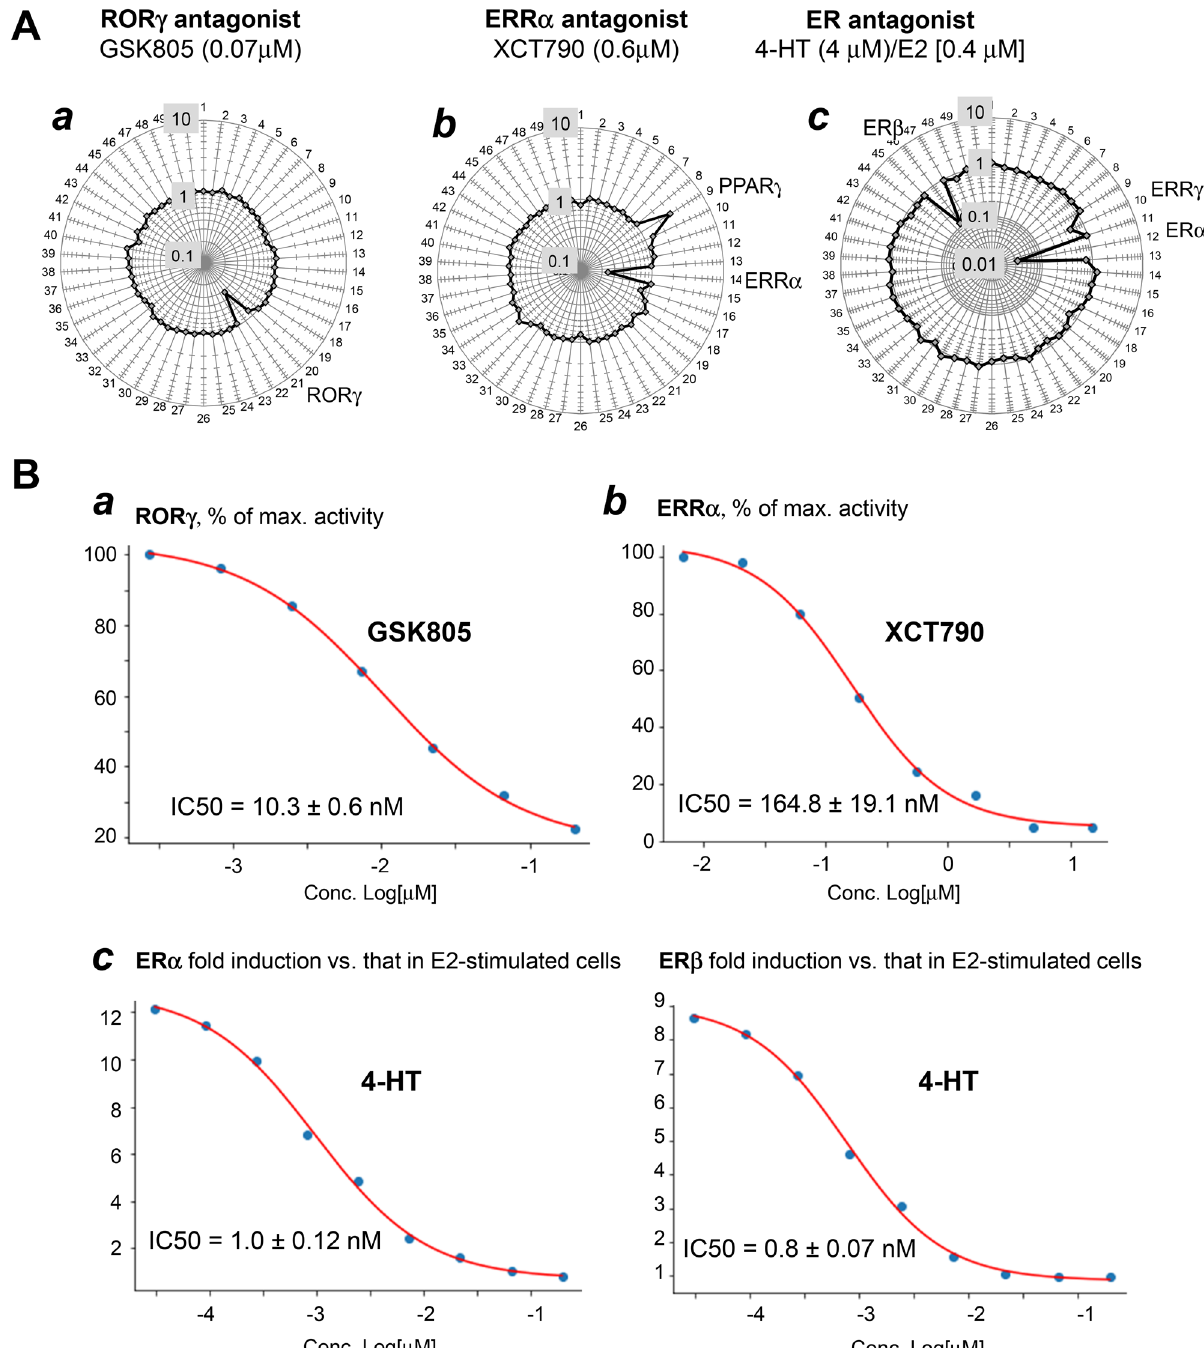
Figure 4. Assessing NR antagonists by the FACTORIAL NR assay. (A) The NR activity profiles for RORγ ( a ), ERRα ( b ), and ER ( c ) antagonists after a 24-h incubation. The log-transformed fold-changes of NR activity in antagonist- vs. vehicle-treated cells are shown. ( c ) To assess ER antagonist 4-HT, cells were stimulated with ER agonist 17β-estradiol (E2). The differential NR activity profile ( c ) shows NR activity changes in cells treated with the combination of E2/4-HT vs. that in E2-treated cells. The ( a–c) profiles are average of three independent replicate FACTORIAL NR assays. ( B ) The concentration-responses of the primary NR targets of RORγ ( a ), ERRα ( b ), and ER ( c ) antagonists in FACTORIAL NR assay. The responses show the percentage of the baseline activity in vehicle-treated ( a,b ). or ( c ) E2-stimulated cells. The inferred EC50 values are average data of three independent FACTORIAL NR